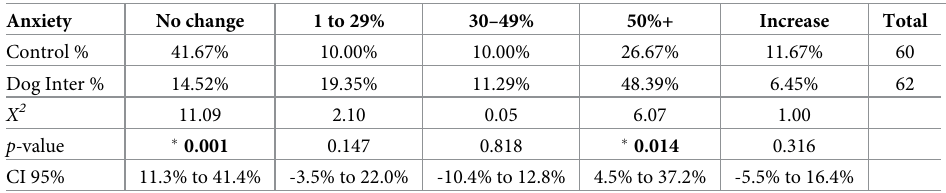
Anxiety response. The control group had a statistically significant larger proportion of participants who had no reduction in anxiety at follow-up compared to the therapy dog team group. Participants with no anxiety, i.e., a recorded anxiety rating of 0 at pre and post, were excluded from anxiety response analysis (41 control, 35 intervention). (see Table 9).